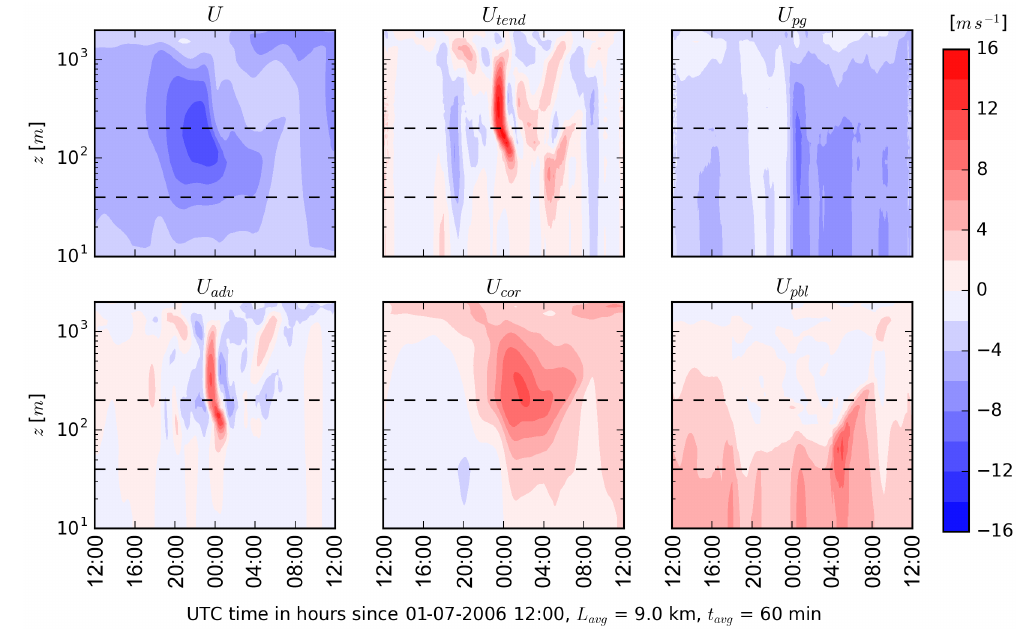
Figure 7. Time–height contour plots of the longitudinal wind component U and momentum budget terms: U tend = U adv + U cor + U pg + U pbl from the WRF–YSU